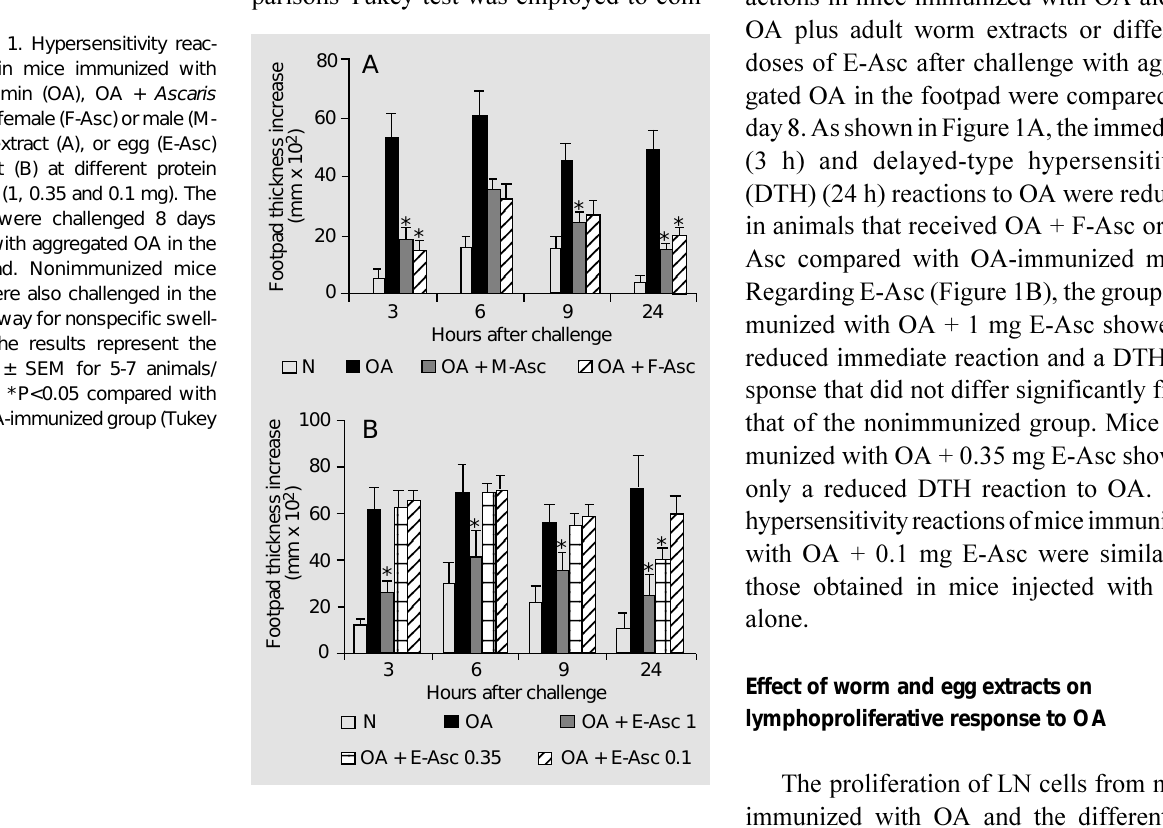
Table 1. Proliferative response of lymph node cells from mice immunized with ovalbu- min (OA) or OA plus female or male adult worm extract. Cells OA F-Asc M-Asc Con A OA 7.9* 1.9 OA + F-Asc 1.0 OA + M-Asc 1.1 Inguinal and periaortic lymph node cells from mice immunized 9 days before with OA, OA + F-Asc or M-Asc in complete Freund’s adjuvant were stimulated with 100 µg/ml OA, 100 µg/ml F-Asc or M-Asc, or 2.5 µg/ml Con A for 96 h. F-Asc, M-Asc = female and male worm extract, respectively; Con A = concanavalin